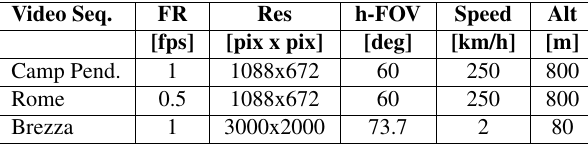
Table 1: Aerial video sequences characteristics.